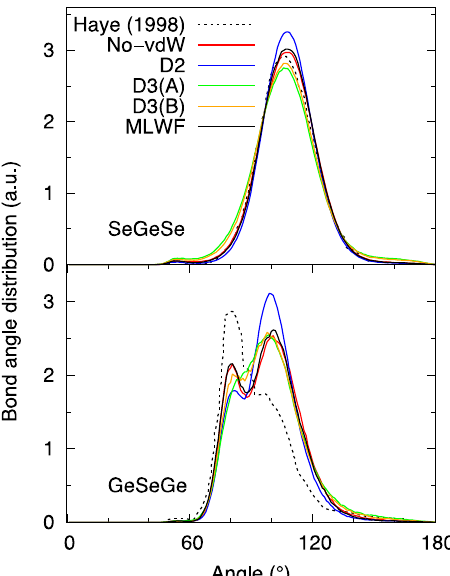
Figure 4. Bond-angle distribution functions (BAD) for liquid GeSe 4 . Haye (1998) stands for Ref. 16.